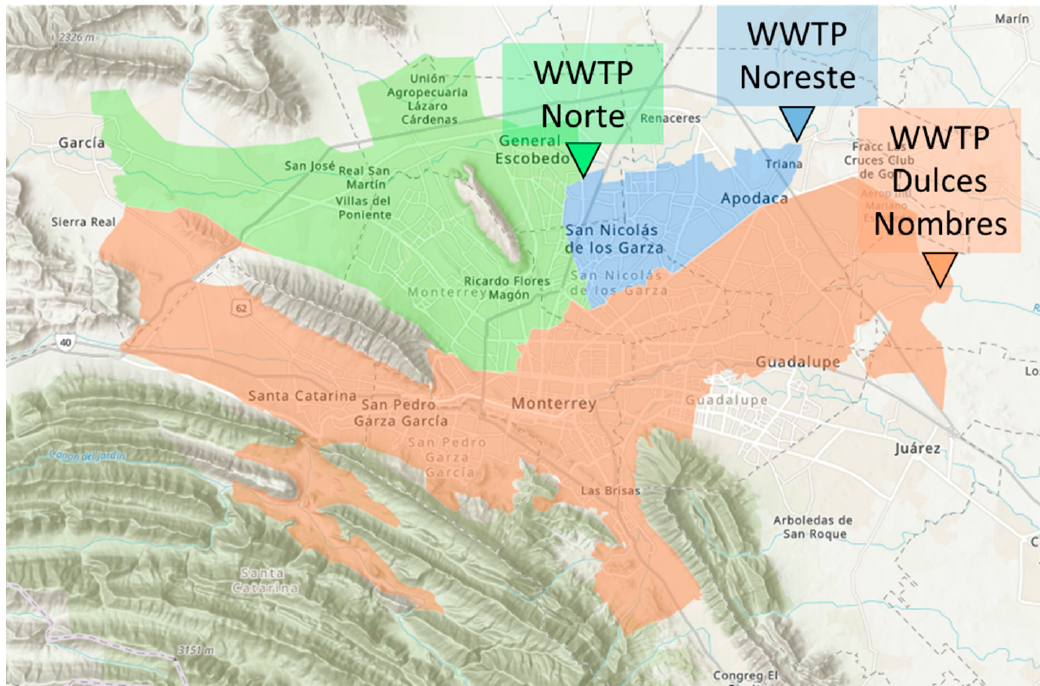
Figure 1. Wastewater catchment area of each wastewater treatment plant, namely, Dulces Nombres (Orange), Norte plant (Green), and Noreste Plant (Blue). The inverted triangles correspond to the WWTP locations. Cadereyta (Cad) WWTP is not shown. Source: Servicios de Agua y Drenaje de Monterrey, 2020.